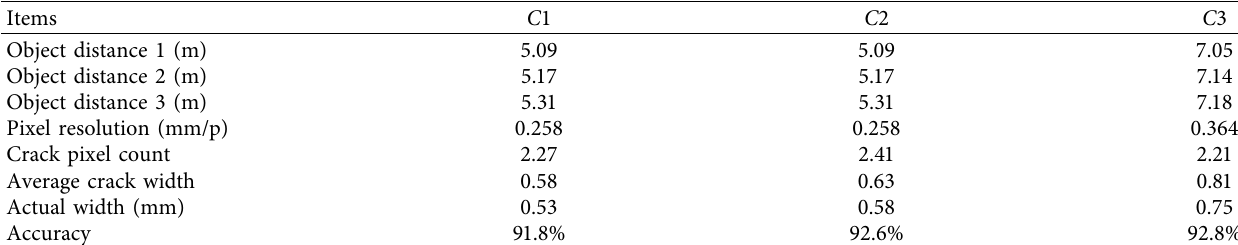
Table 17: Identification of image crack